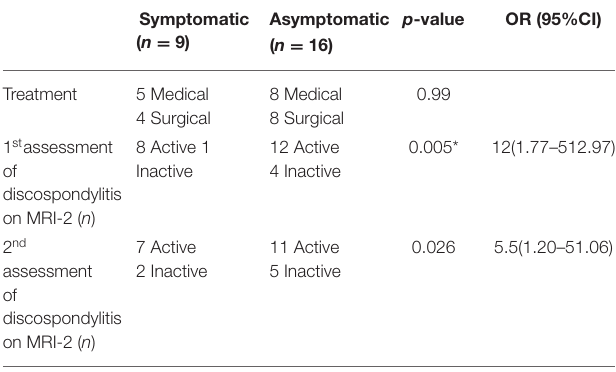
TABLE 2 | Type of treatment between MRI-1 (magnetic resonance imaging at initial presentation) and MRI-2 (follow-up), defined subjectively as active or inactive discospondylitis after MRI-2 in symptomatic and asymptomatic